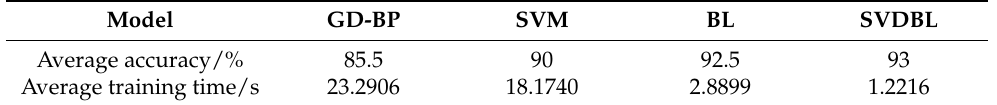
Table 6. Comparison of average prediction accuracy and average training time of each model.